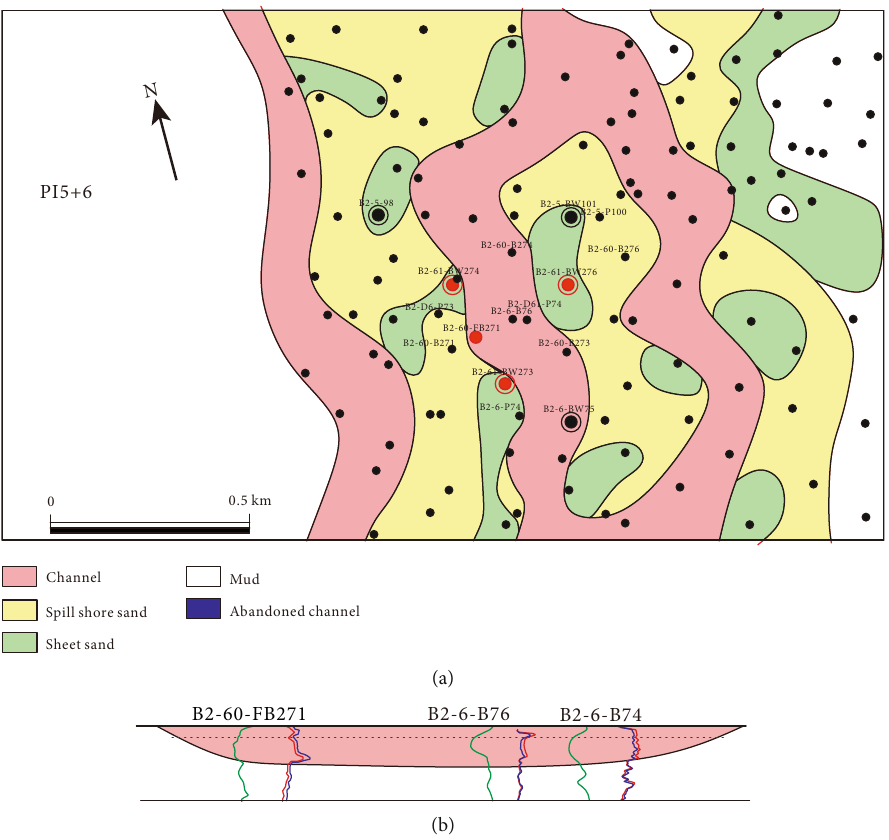
Figure 7: (a) Plane-view of the channel patterns in the PI5+6 layer. (b) Vertical pro fi le of the channel in the PI5+6 layer.